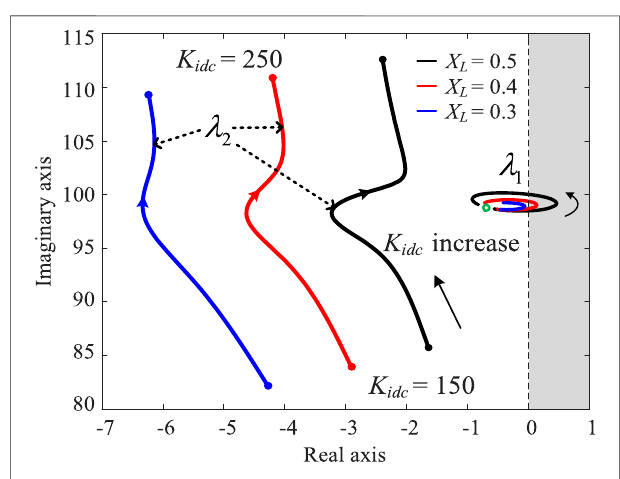
FIGURE7| Rootlociof λ 1 and λ 2 withchange in K idc underdifferentgrid connection strengths.